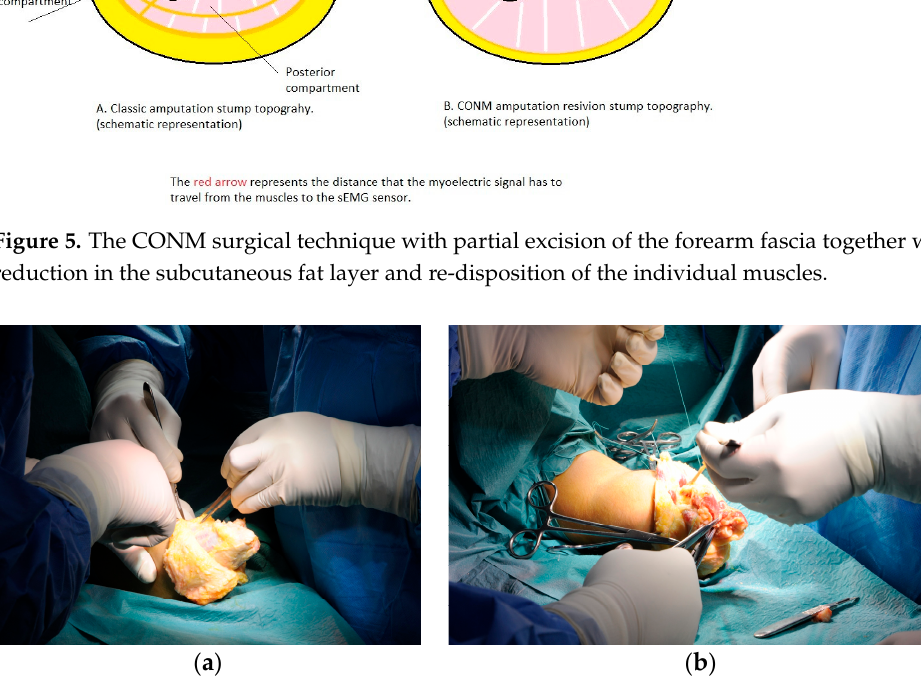
Figure 6. A live intraoperative view of the CONM technique: ( a ) Partial excision of the forearm fascia; ( b ) circumferential transposition of the muscle groups.